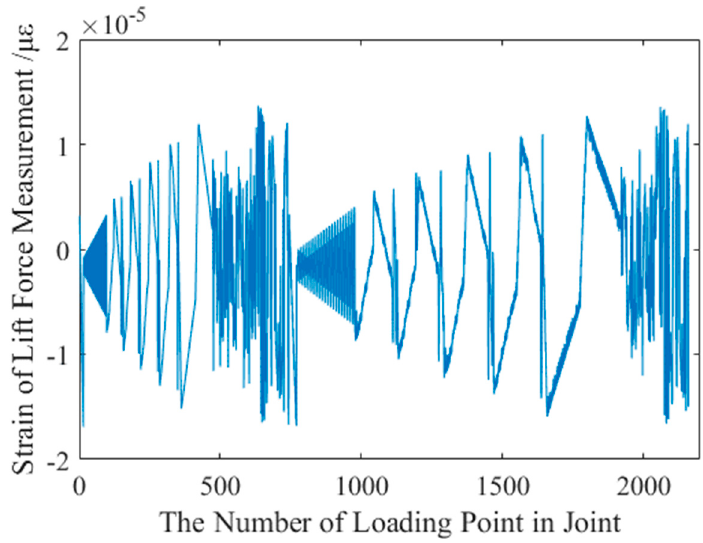
Figure 8. Analysis of the transmission characteristics of the joint.